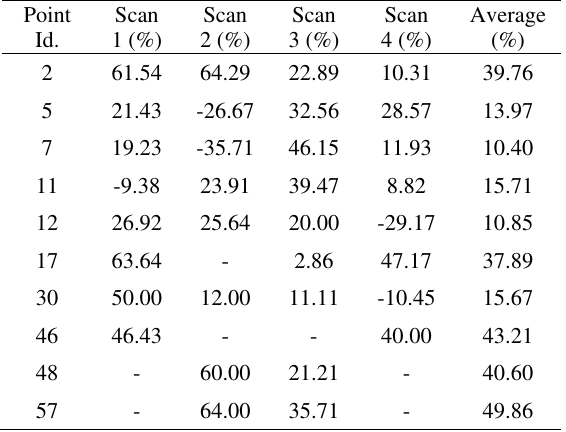
Table 8: Percentage of improvement associated to each check point in its respective scan for the FARO LS